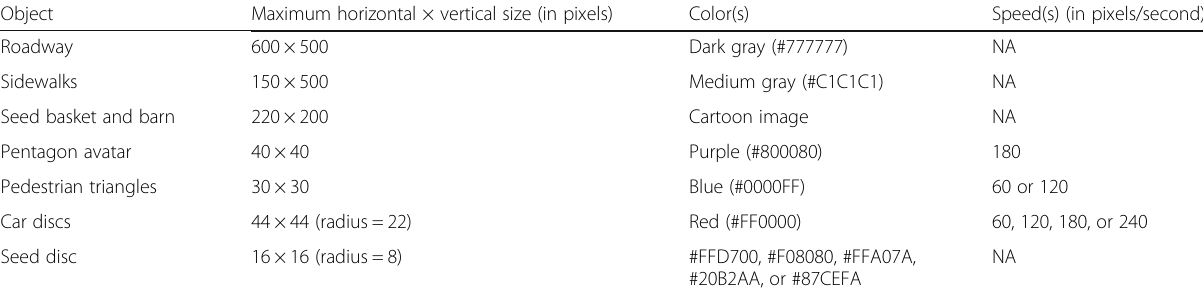
Table 1 Appearance and behavior details for the objects used in the game; these parameters were consistent across experiments